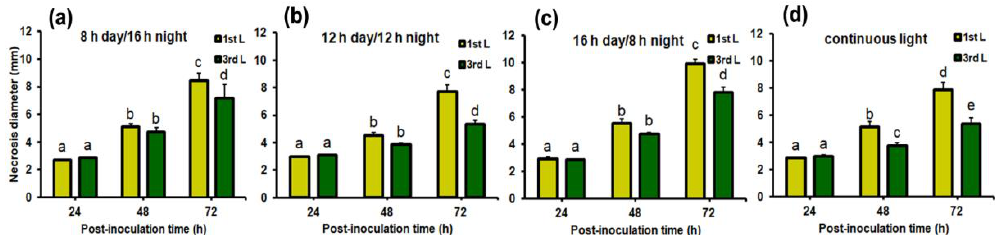
Figure 2. Necrosis development on the 1st and 3rd leaf of A. brassicicola -infected B. juncea plants grown under different day-length regimes: ( a ) 8 h day/16 h night; ( b ) 12 h day/12 h night; ( c ) 16 h day/8 h night; and ( d ) continuous light. The mean values ± SE were obtained in four independent experiments ( n = 4). Different letters indicate a significant difference between the means within a photoperiod according to a post-hoc Duncan ’ s test ( p < 0.05). Abbreviations: 1st L, first leaf; 3rd L, third leaf.